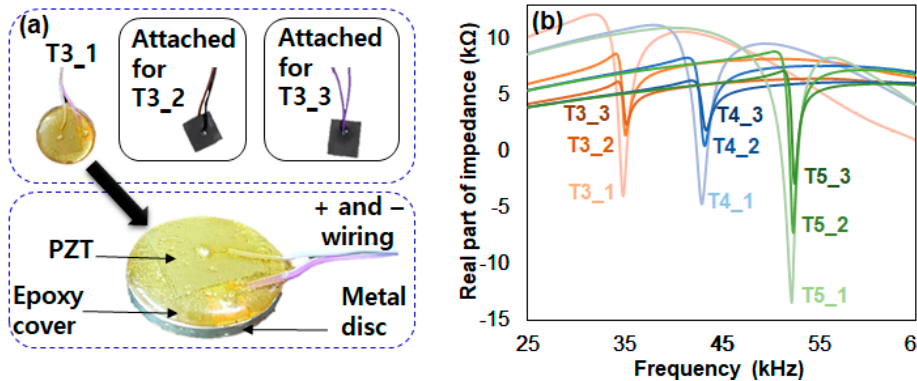
Figure 4. Different PZT attachment ( a ) configuration; ( b ) device impedance signatures.